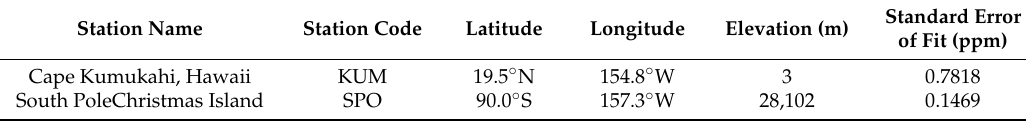
Table A4. CO 2 observation stations and standard error of fit from Keeling et al.